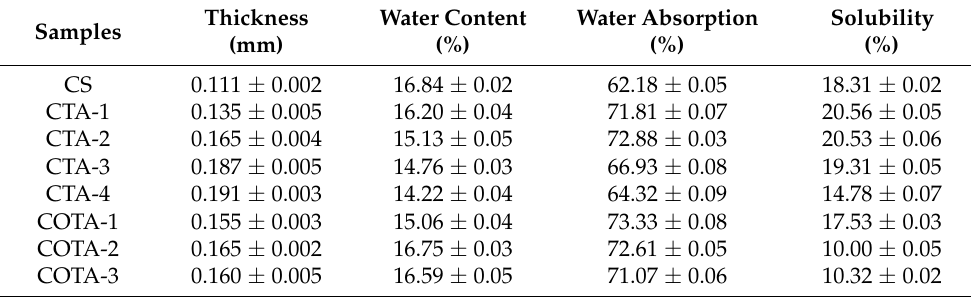
Table 5. The solubility, moisture content, and water uptake of CS-based films. Thickness Water Samples (mm)